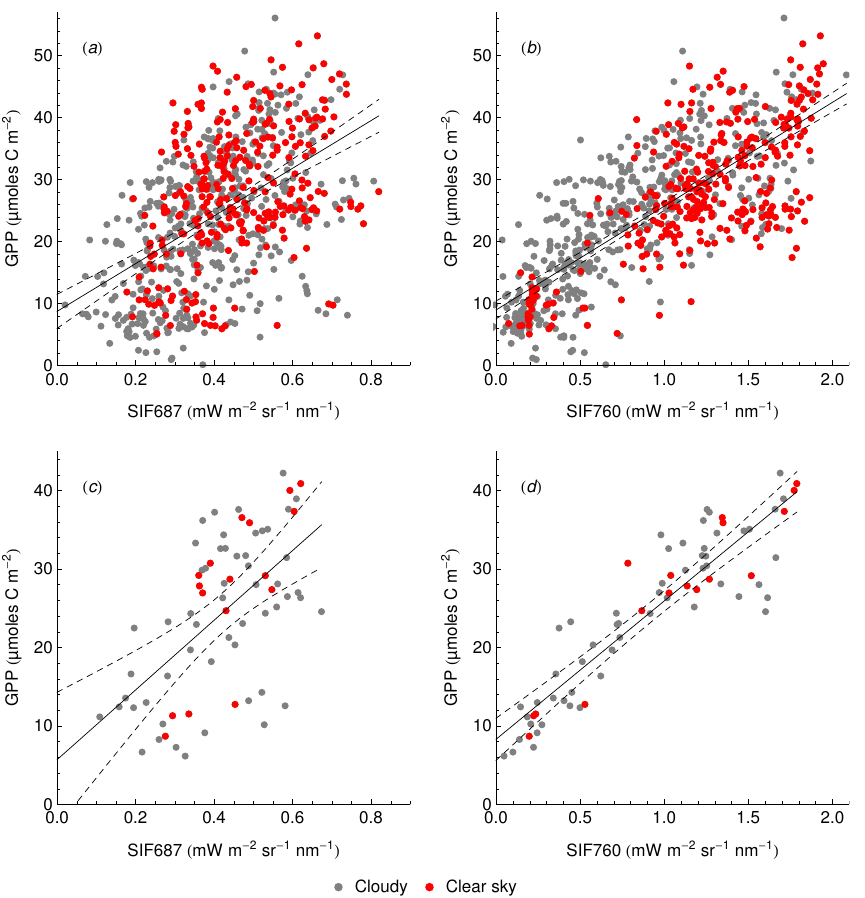
Figure 7. ( a – d ) Scatter plots of GPP and SIF. ( a , b ) Half-hourly averages; ( c , d ) Daily averages over the period 8:00–15:30 UTC; ( a , c ) GPP is plotted against red SIF in the O 2 B band (SIF687); ( b , d ) GPP is plotted against far red SIF in the O 2 -A band (SIF760). Red (gray) points indicate clear (overcast) sky conditions. Coefficients of determination of the linear regression between GPP and SIF and ± 1 σ confidence bands are reported. All data points are considered in the regressions presented here.